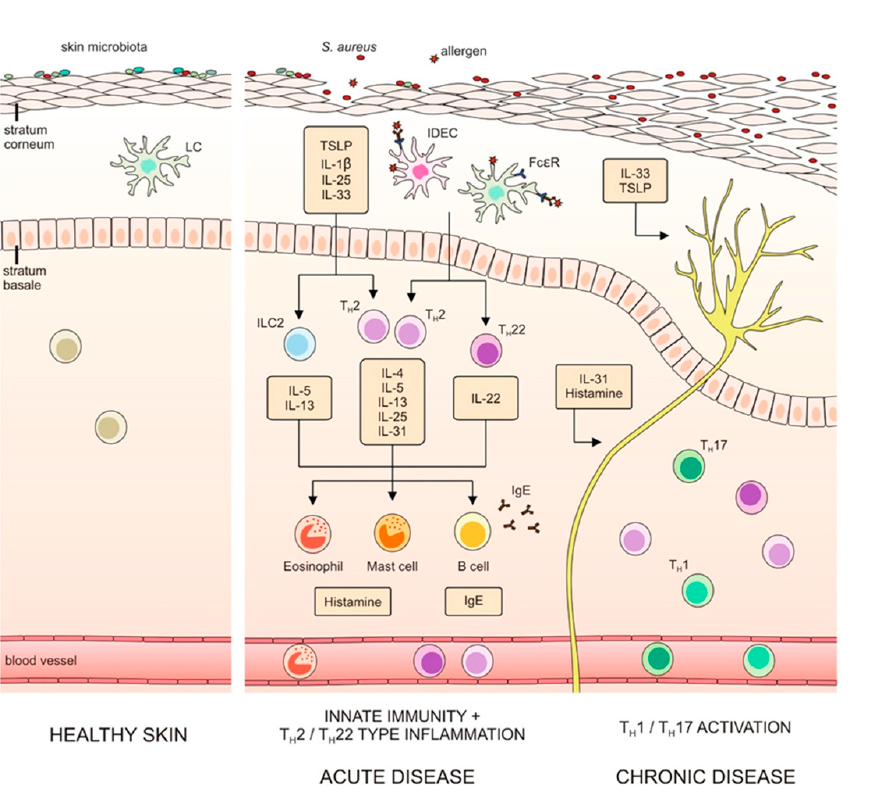
Figure 1. Dependence between epithelial barrier dysfunction, type 2 immunity and itch (with the authors’ consent) [15].